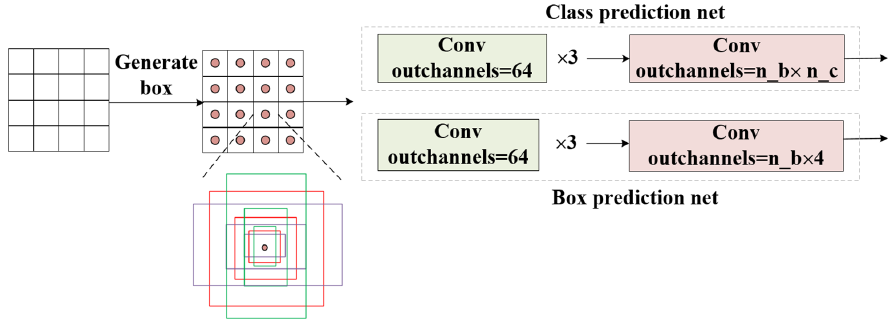
Figure 6. Classification regression